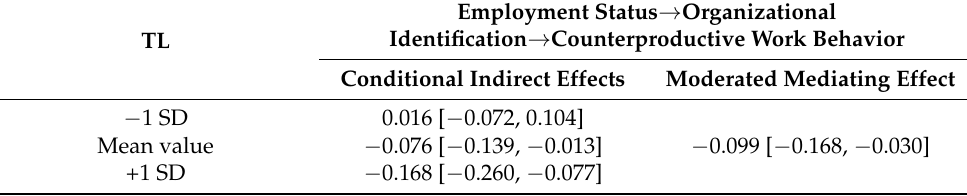
Figure 3. Interaction between employment status and turnover intention on CWB. Table 6. Result of moderated mediating effect.